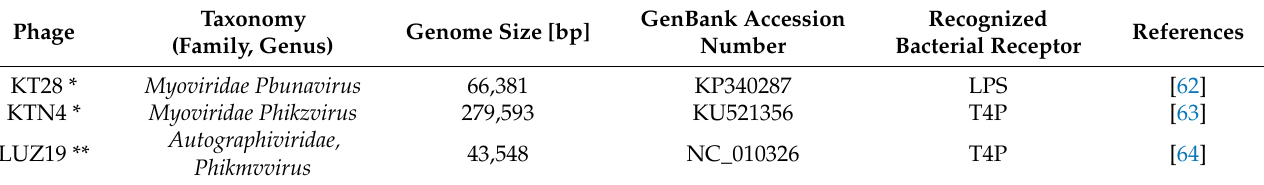
Table 3. Characteristics of phages used in the